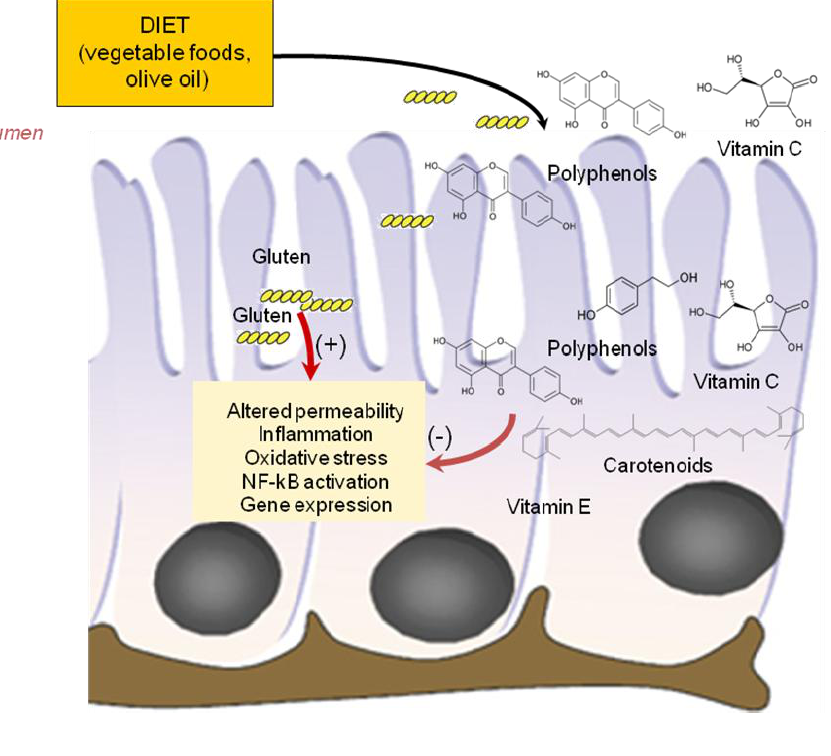
Figure 3. Protective effect of phytonutrients on cytotoxicity of gluten peptides. Antioxidant vitamins (vitamin C and E), polyphenols and carotenoids from dietary vegetable food and oil, were absorbed by intestinal cells and could exert protective effects against toxic effects exerted by gluten peptides on intestinal